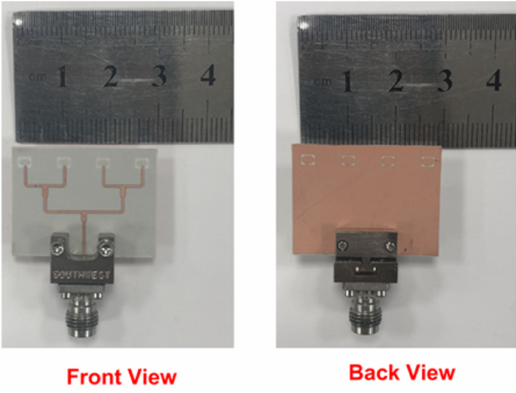
Figure 7. The fabricated 1 × 4 antenna array photo.